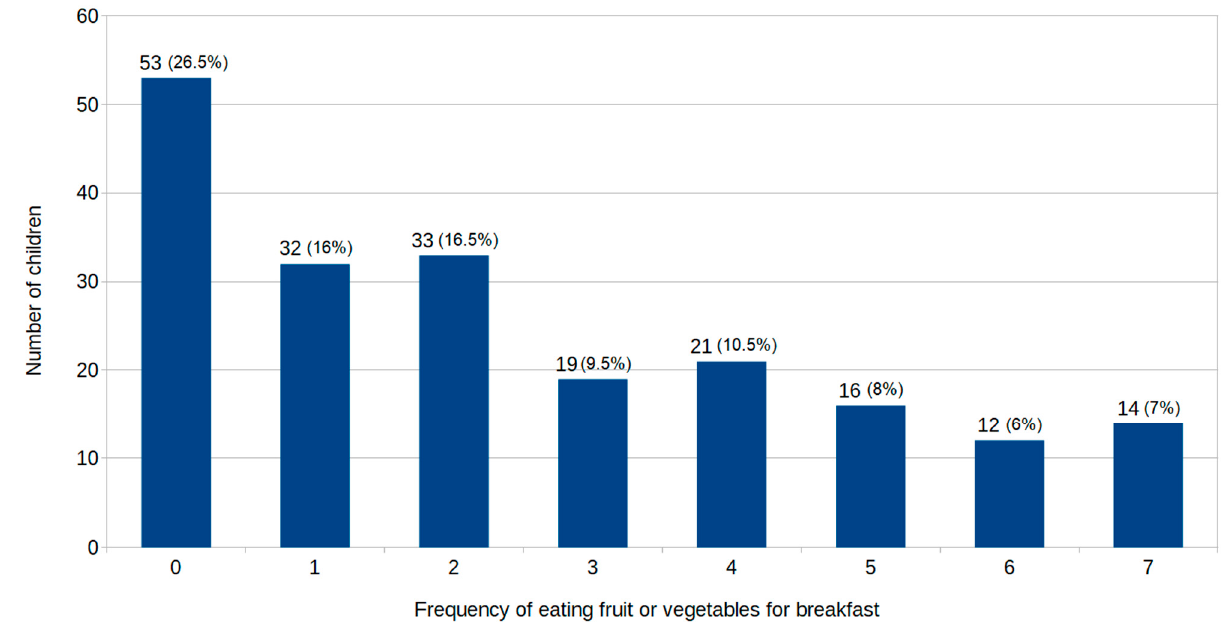
Figure 4. Frequency of fruit and vegetable consumption for breakfast.